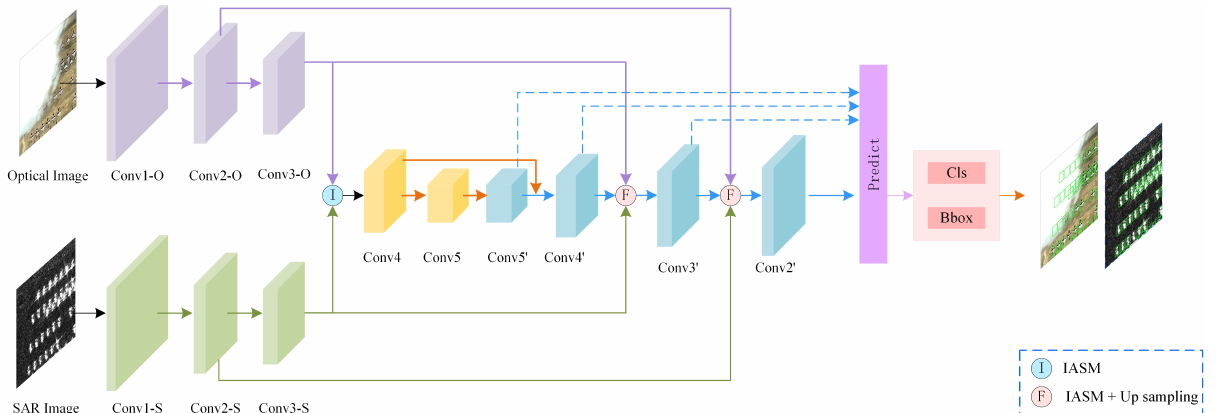
Figure 2. Framework of the proposed MIN. Purple and green modules are feature extraction streams of the optical image and the SAR image, respectively. Blue circle is the Interactive Attention Sum-Max fusion module (IASM). The pink circle is the Feature Pyramid Network (FPN) with